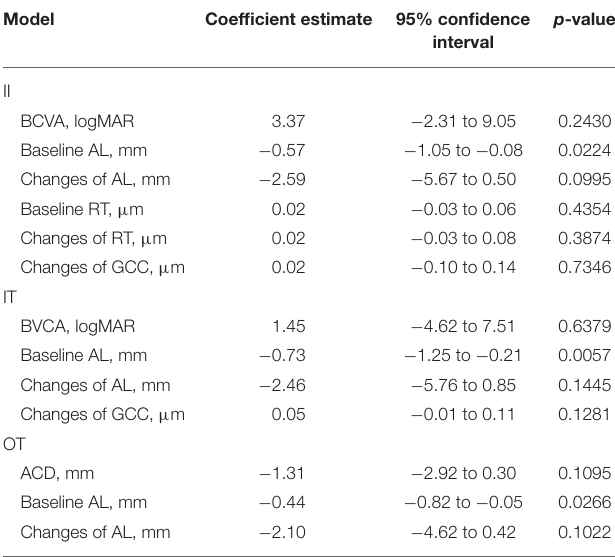
TABLE 3 | Multivariate regression analysis of association with changes of sectoral VD in all participants. Model Coefficient estimate 95% confidence